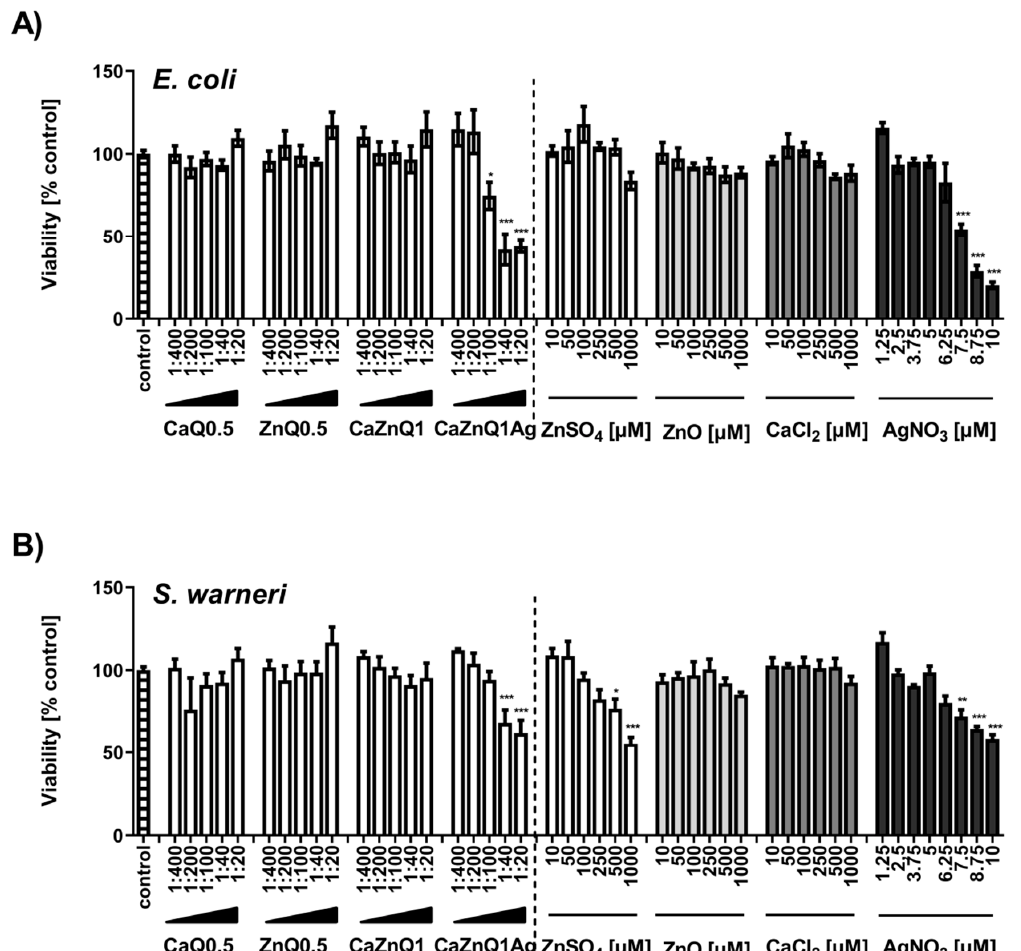
Figure 3. Effect of aerogel soluble mediators on bacterial metabolic activity. Viability of E. coli ( A ) or S. warneri ( B ) after 3h culture in the presence of aerogel swelling supernatant dilutions or metal salt